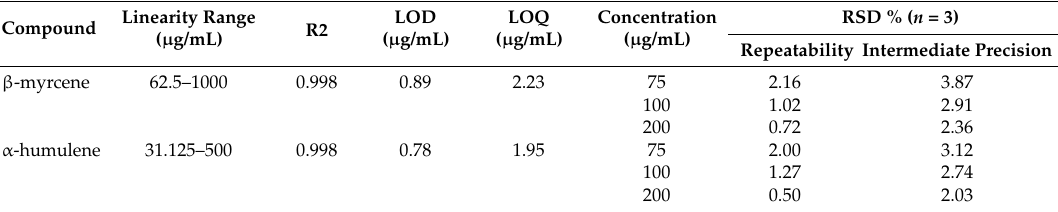
Table 2. Calibration data as well as repeatability and intermediate precision for analyzing β -myrcene and α -humulene by UPC 2